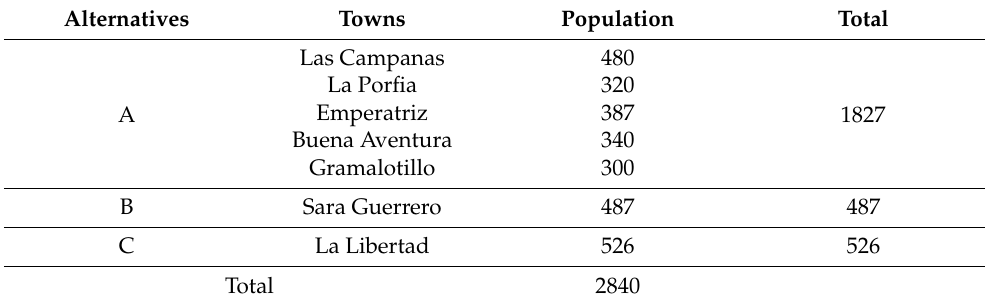
Table 1. The population that is possibly affected by the implementation of the dam in each alternative